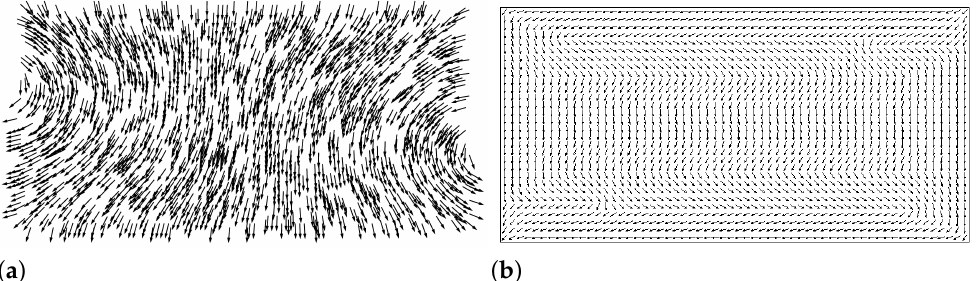
Figure A2. Distribution of the remanent magnetization vector after applying the magnetic field along the short axis: ( a ) obtained by us, ( b )